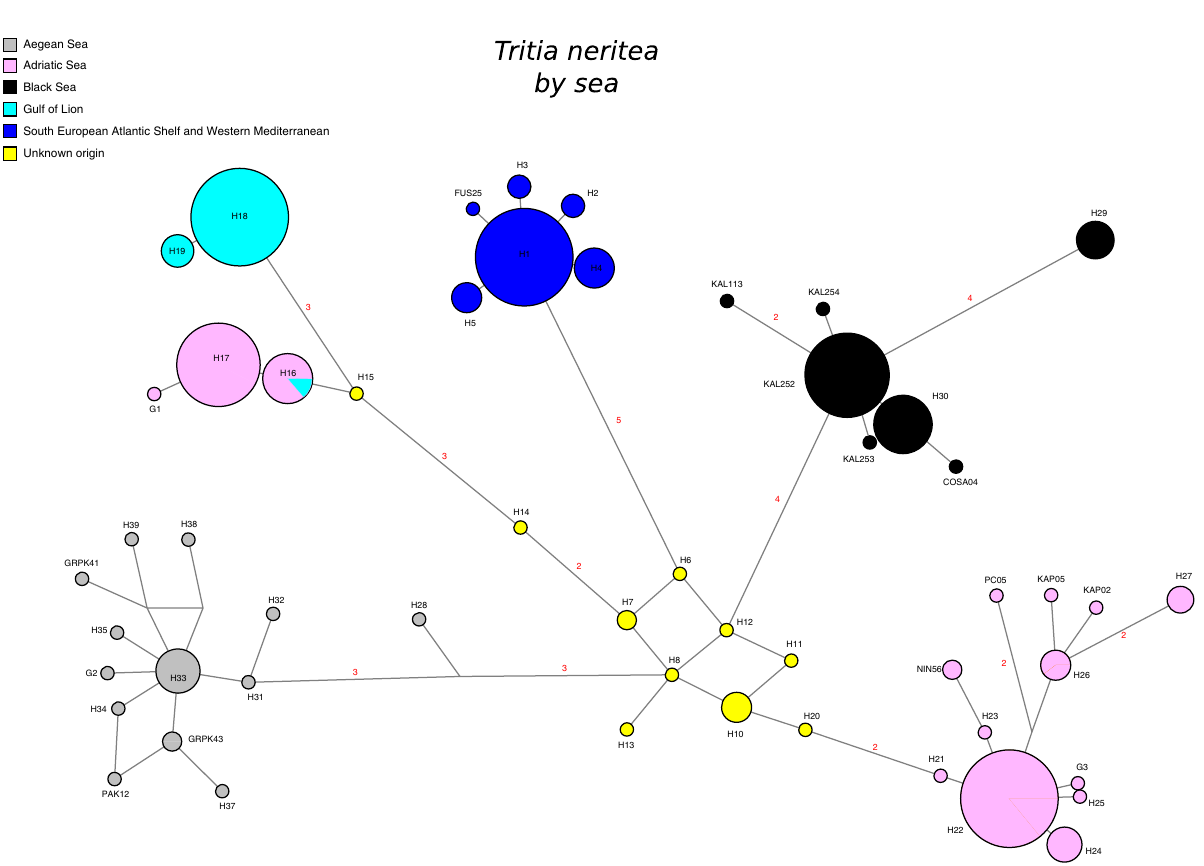
Figure 2. Median joining network of haplotypes of the 128 COI sequences of Tritia neritea generated for this study together with haplotypes available in GenBank. Circle sizes are proportional to the number of sequences per haplotype. Distances are proportional to the number of mutations between haplotypes. Numbers in red indicate numbers of mutations between haplotypes. The haplotypes marked as unknown origin were sampled in an introduced area, the Bay of Biscay 46 , but the population of origin in the native area is